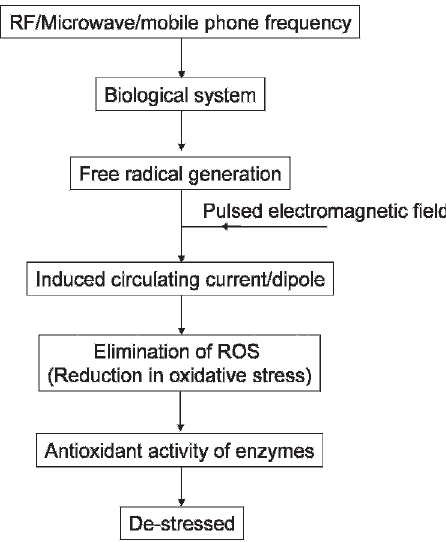
Figure 9 - A pathway describing the mechanism of a pulsed electromagnetic